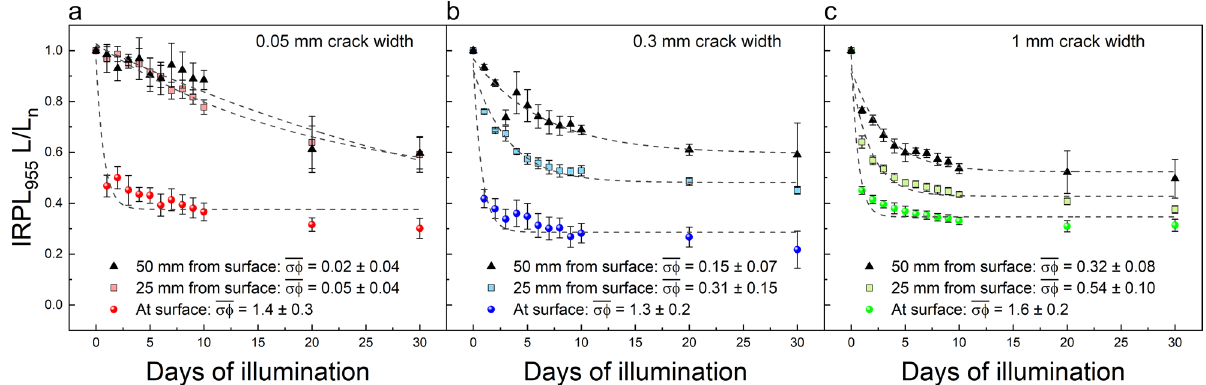
Figure 4. Dependence of normalized IRPL 955 values at the crack surface on the exposure duration. Values were extracted at 0, 25 and 50 mm distances from the top surface for the ( a ) 0.05, ( b ) 0.3 and ( c ) 1 mm crack widths. Dashed curves show the best fit of Eq. (1) to the data.